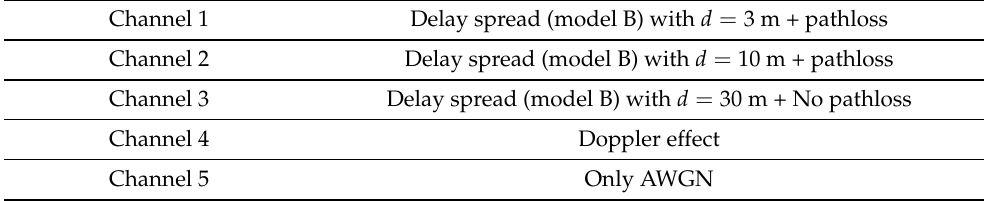
Table A2. The channel propagation conditions H ( x ) for IEEE 802.11 protocols.